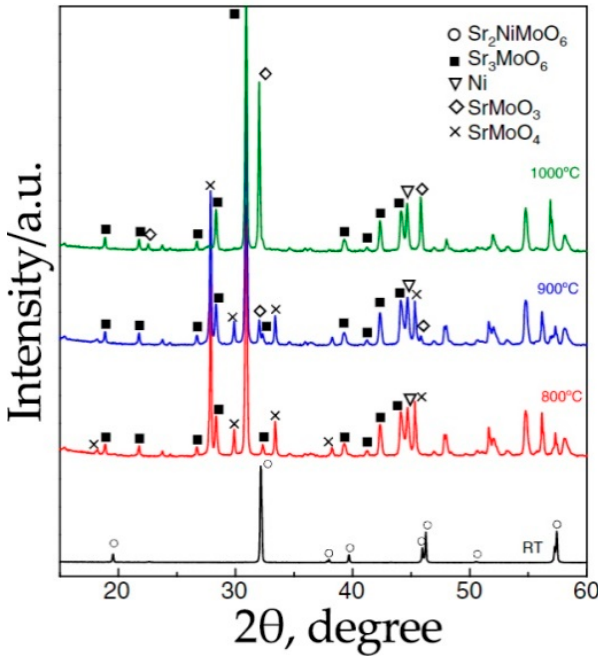
Figure 5. XRD patterns recorded for Sr 2 NiMoO 6- δ calcined in 5%H 2 /Ar at different temperatures for 24 h. Reproduced with permission [91]. Copyright 2013,